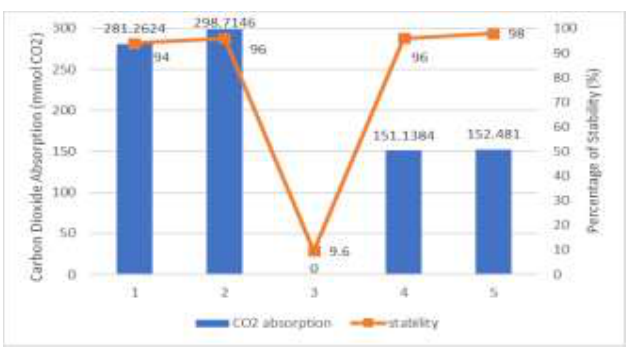
Figure 6: Relationship between amount of CO 2 absorbed and stability of an emulsion It is also suggested that the use of cosurfactant DOPC/Span 80 has produced a stable emulsion, but it does not facilitate CO 2 absorption due to its molecular structure as shown in Figure 7. As it forms an adhesive emulsion and it also create a resistance for CO 2 to pass through and diffuse through the interface layer.